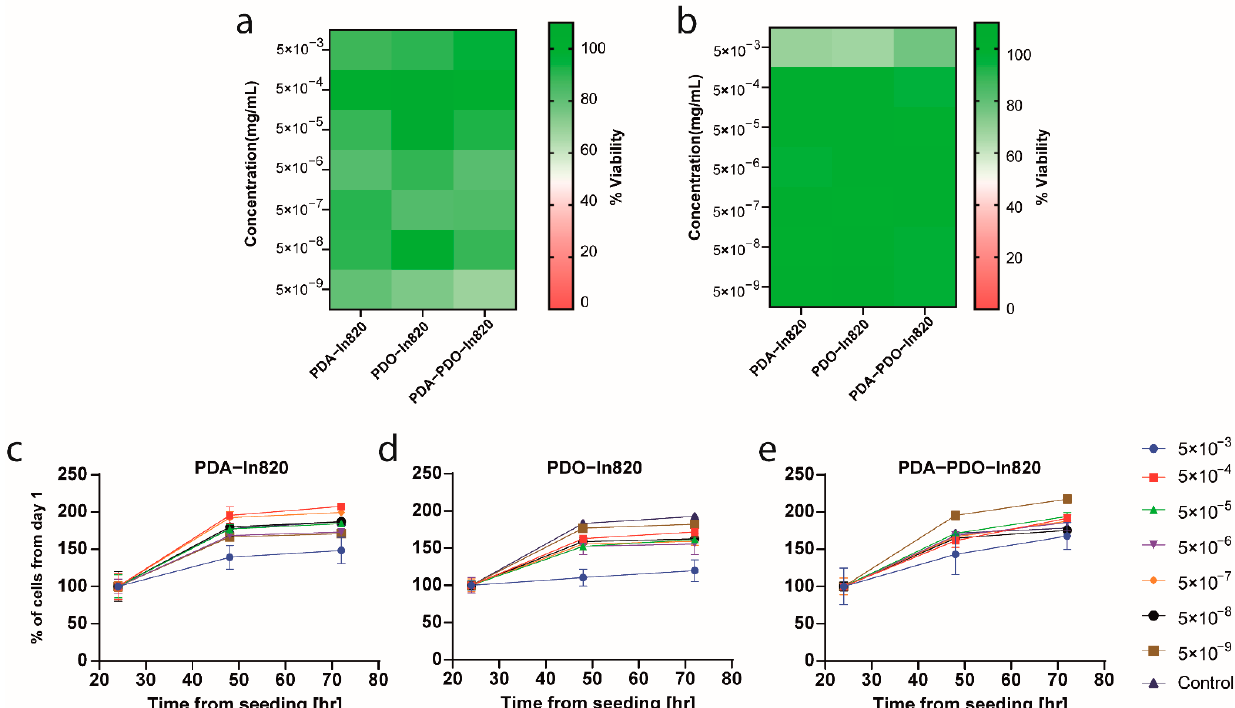
Figure 6. In vitro toxicity assay in mouse embryonic fibroblasts, 3T3 cells. ( a ) MTT after 3 days of incubation with different copolymers. ( b ) Cell viability assay using image-based cell count after 3 days of incubation with different copolymers. ( c – e ) Image-based cell counting at various times of incubation with different copolymers. Error bars represent standard deviation.